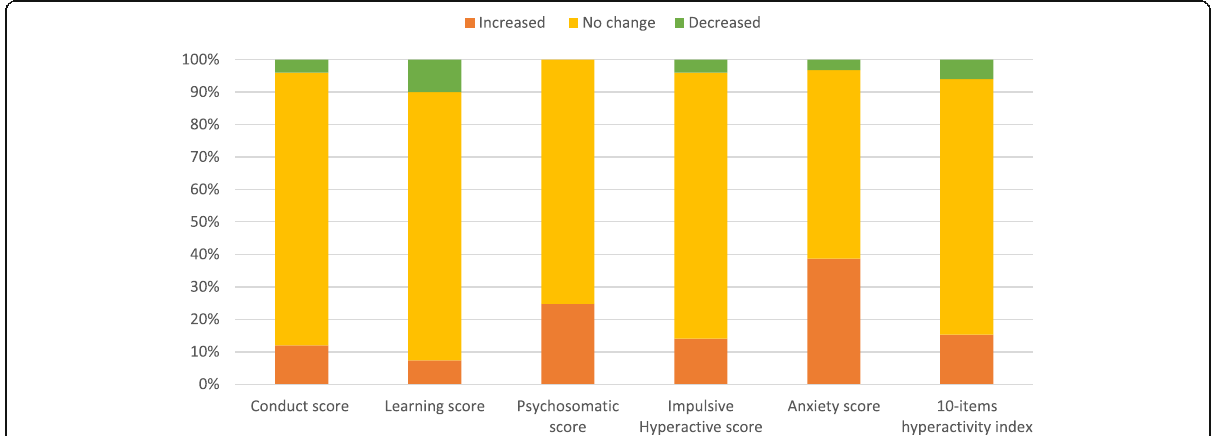
Fig. 1 Change in Conners ’ 3rd edition (PARENT Short Form) scale during COVID-19 pandemic compared to before the